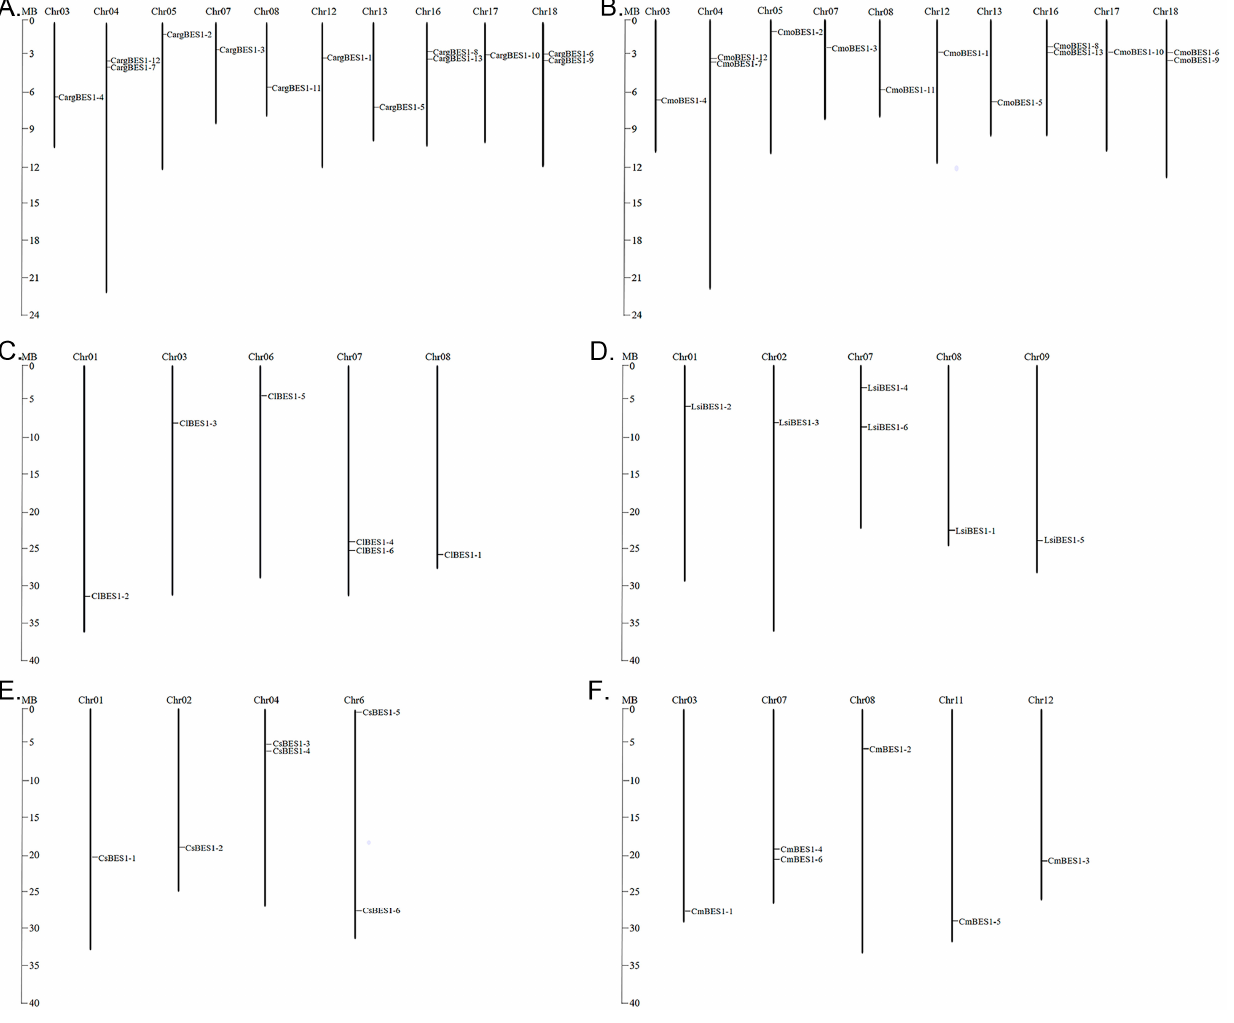
Figure 2. Localization of BES1 genes on the chromosomes of six Cucurbitaceae species. ( A ) Localization of CargBES1 genes on the chromosome of silver-seed gourd, ( B ) localization of CmoBES1 genes on the chromosome of winter squash, ( C ) localization of CIBES1 genes on the chromosome of watermelon, ( D ) localization of LsiBES1 genes on the chromosome of bottle gourd, ( E ) localization of CsBES1 genes on the chromosome of cucumber, and ( F ) localization of CmBES1 genes on the chromosome of melon. The chromosome number was labelled on the top of each chromosome. The left scale represents the length of chromosomes, and scale is expressed in megabase (MB).